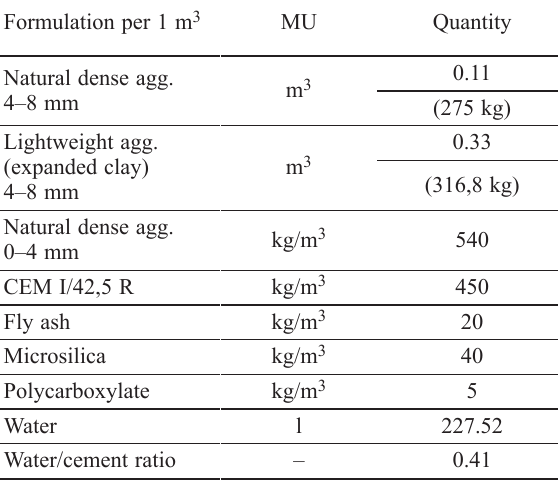
Table 2. Formulation B